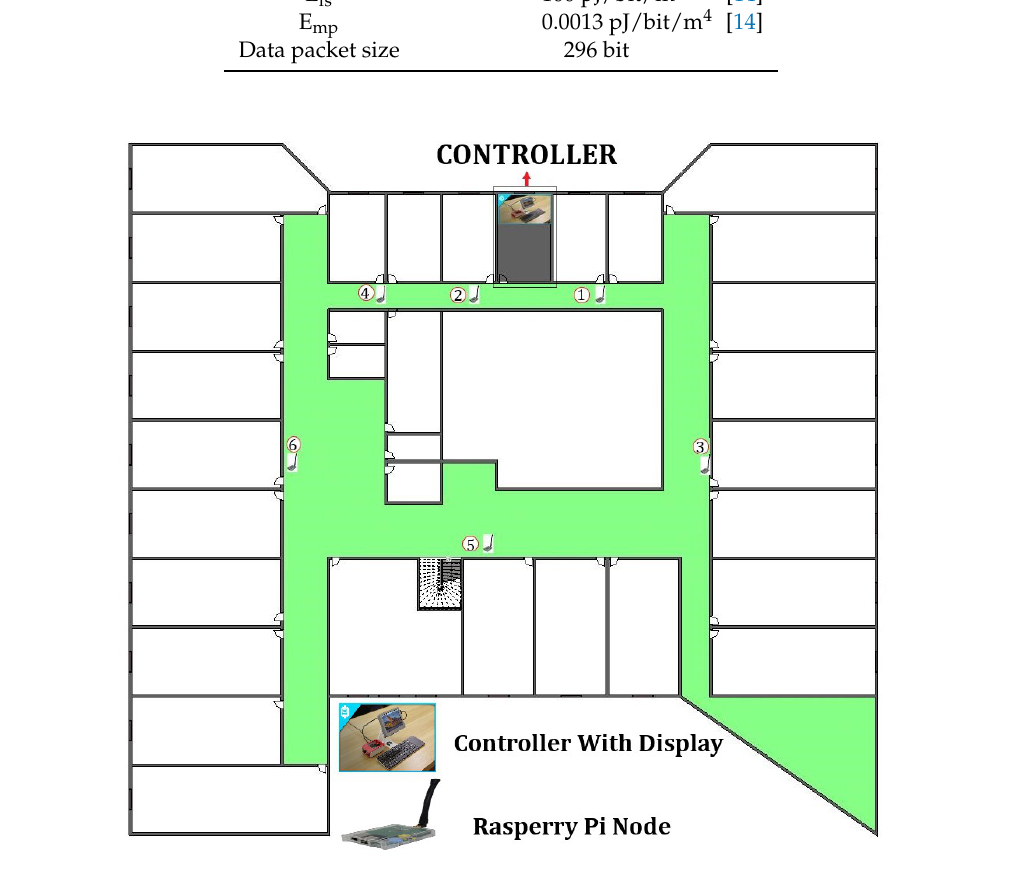
Figure 10. Raspberry Pi nodes deployment structure on the fourth floor of IRIT-1